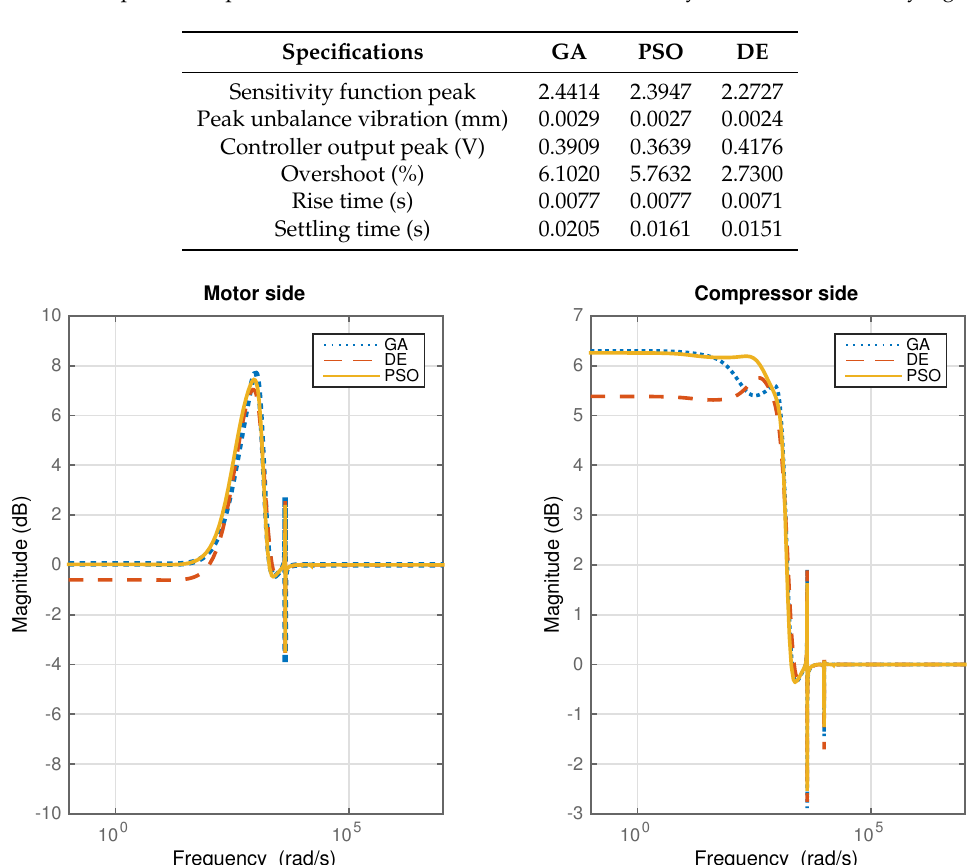
Table 4. Comparison of performances of the FOPID controllers tuned by different evolutionary algorithms.